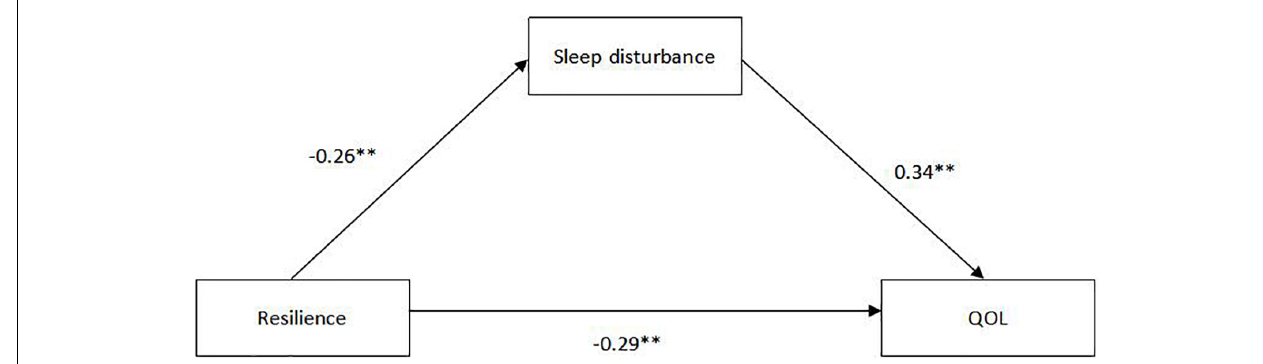
FIGURE 2 | The structural equation modeling of the relationship between resilience and QoL mediated by sleep disturbance.